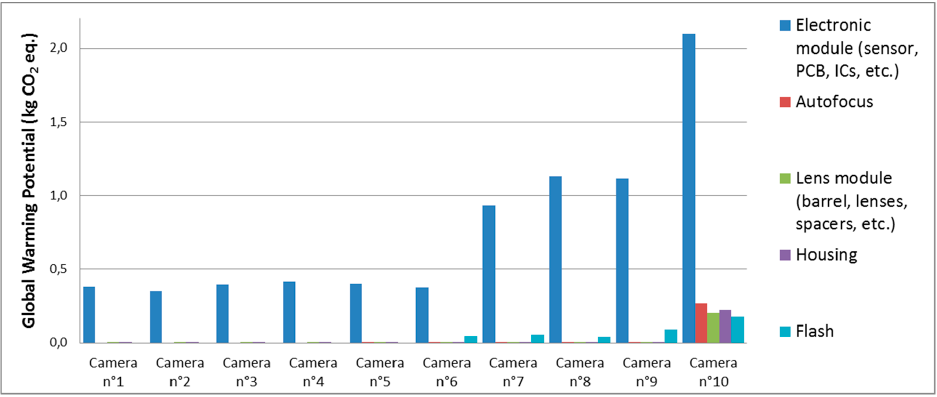
Figure 3. GWPI results for ten different camera modules.